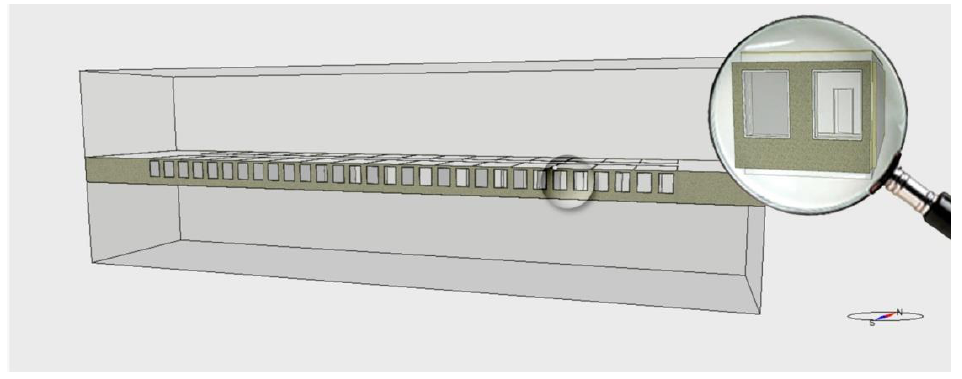
Figure 2. Schematic view of the reference model for an office building.